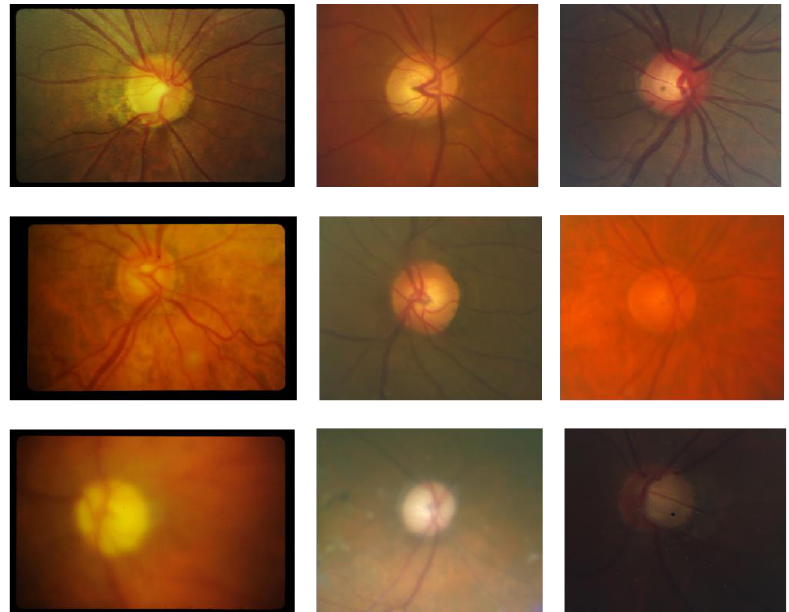
Figure 1. Standard reference photographs for each image quality class.